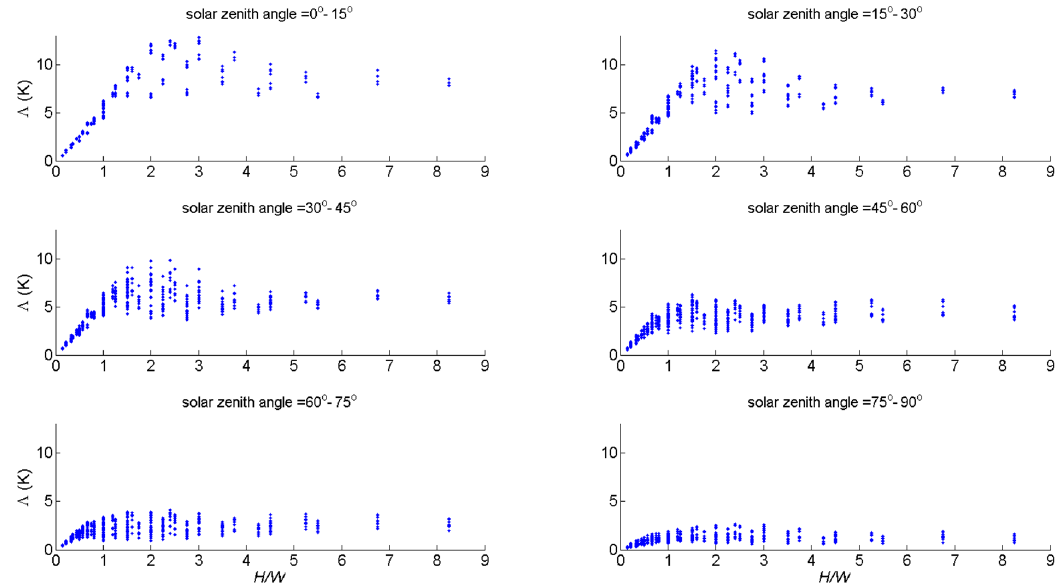
Figure 7. Maximum anisotropy as a function of building height to street width ratio H/W for all latitudes and hours 1200–2000 LST (inclusive) on 21 June. Values are averaged over all street orientations.